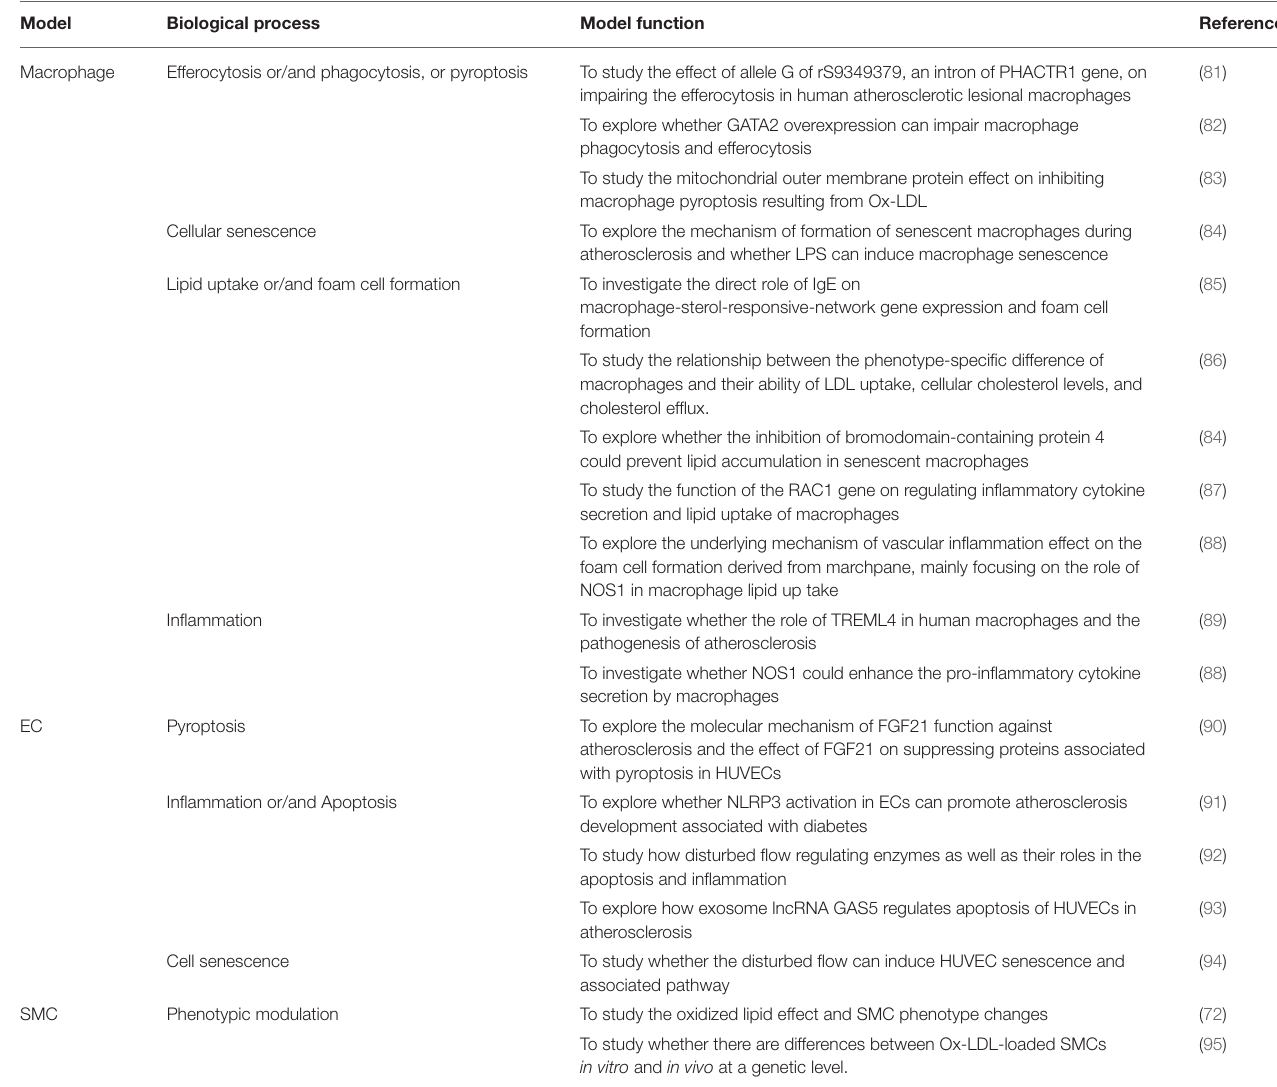
TABLE 2 | Some examples in recent studies using a single-cell model for atherosclerosis mechanism exploration.